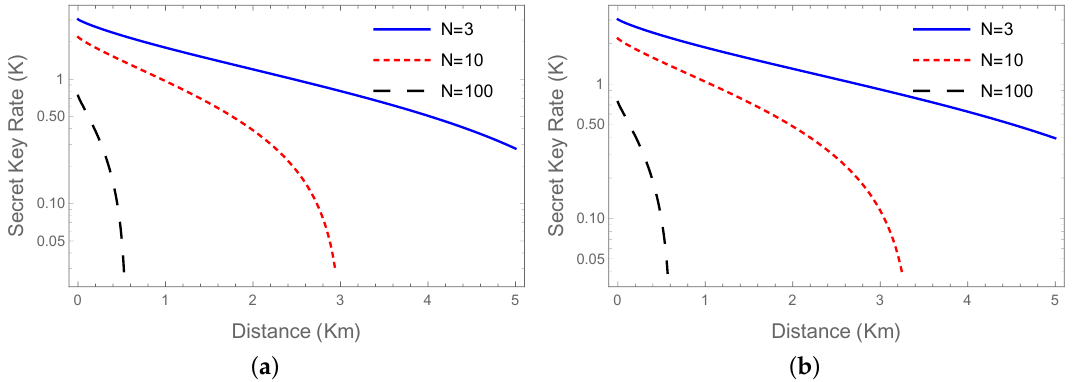
Figure 2. The performance analysis of the entanglement-based multipartite CV quantum conferencing scheme in terms of the derived secret key rate. The curves represent the conferencing key rate as a function of the radius of the network, in conditions of N = 3 (solid blue line), N = 10 (small dashed red line) and N = 100 (large dashed black line) of users, respectively. The thermal noise is set to ¯ n = 0.05 in ( a ) and ¯ n = 0 in ( b ),